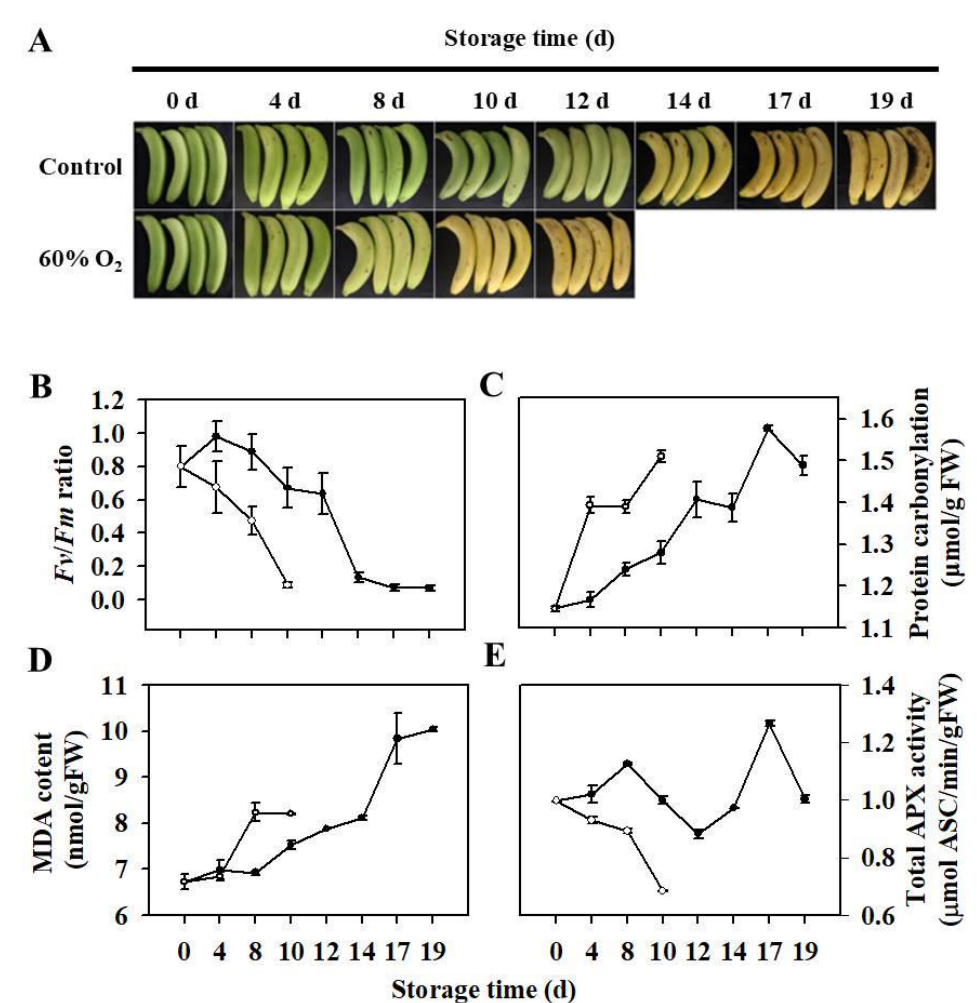
1 Figure 1. Ripening and senescence characteristics, and redox status of banana fruit stored under 60% O were stored under normal air conditions as the control. Changes in ripening phenotype ( A ), Fv/Fm ( B ), protein carbonylation ( C ), malondialdehyde (MDA) content ( D ), and ascorbate peroxidase (APX) activity ( E ) of banana fruit during